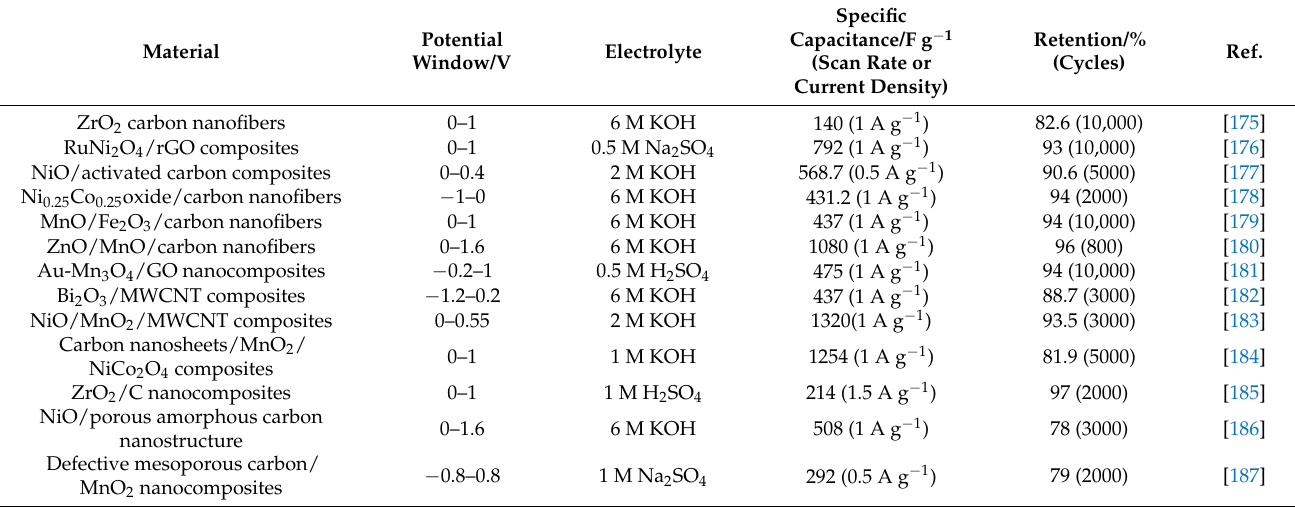
Table 2. Summary of various metal oxide/carbon composite electrodes for